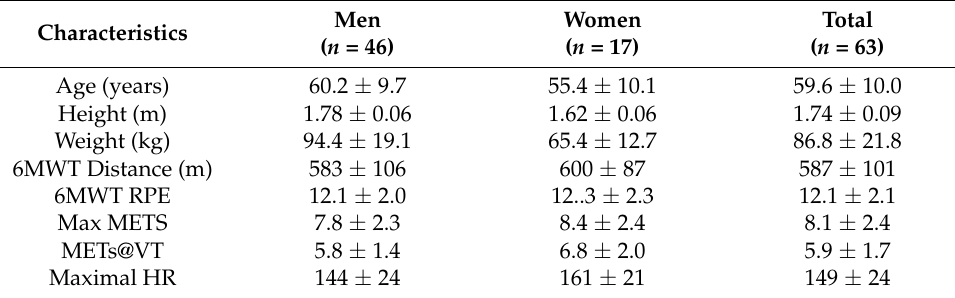
Table 1. Mean and standard deviation of the characteristics of the subjects. Characteristics